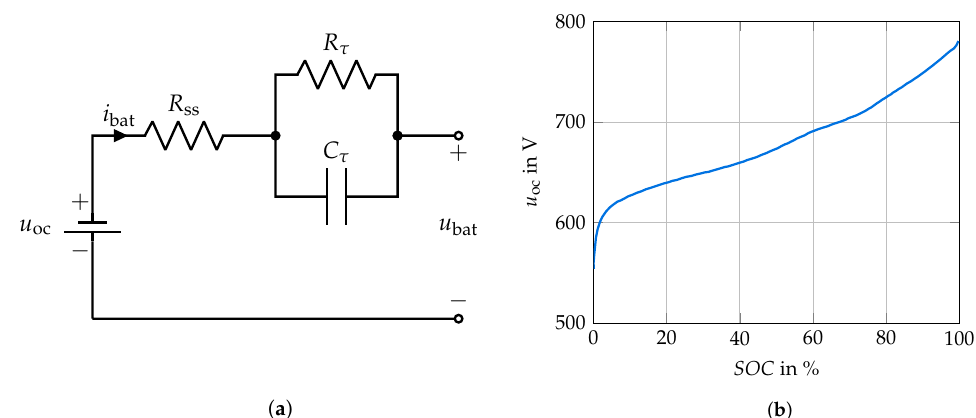
Figure 3. The Thévenin equivalent circuit model of the battery and the relationship between battery open-circuit voltage u oc and SOC . ( a ) Thévenin equivalent circuit model. ( b ) Open-circuit voltage u oc over SOC [28].